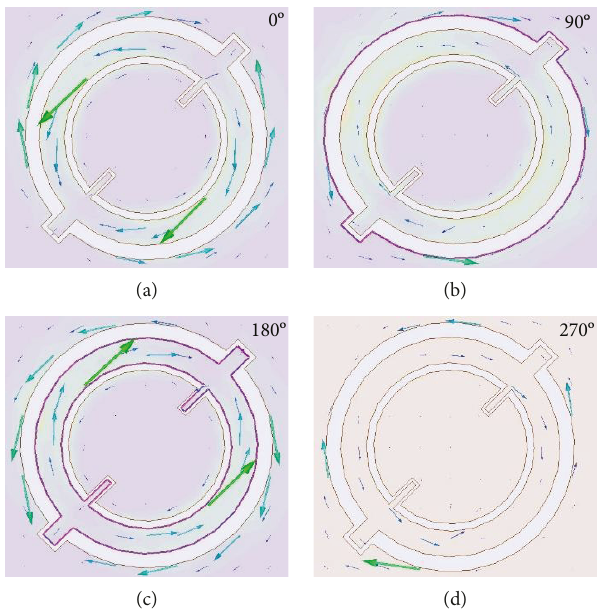
Figure 3: The current distribution for di ff erent phase angles at 2.45GHz.